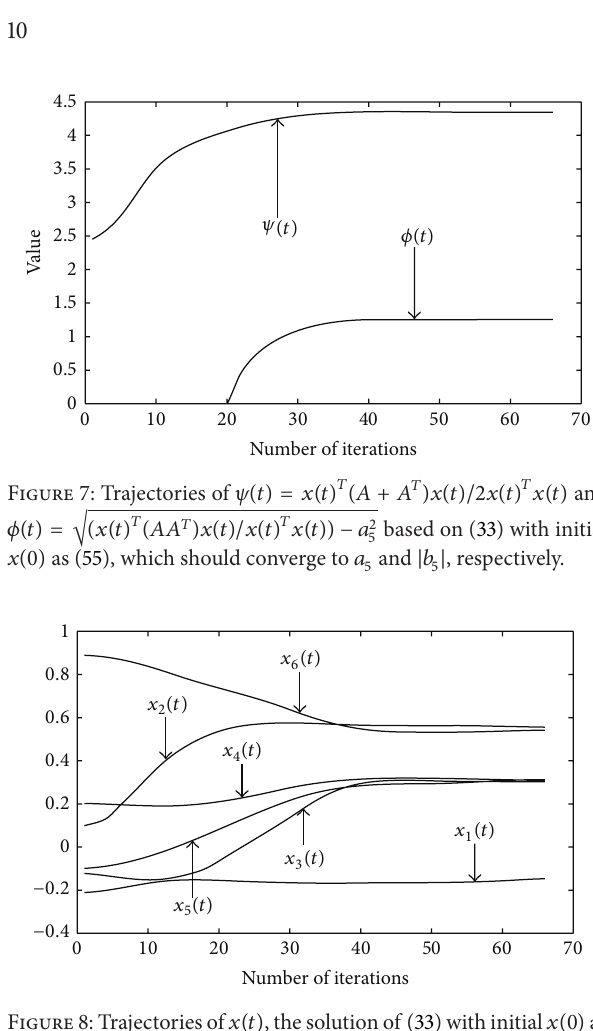
2 based on (40) with initial |𝑏 | , 2 and 2